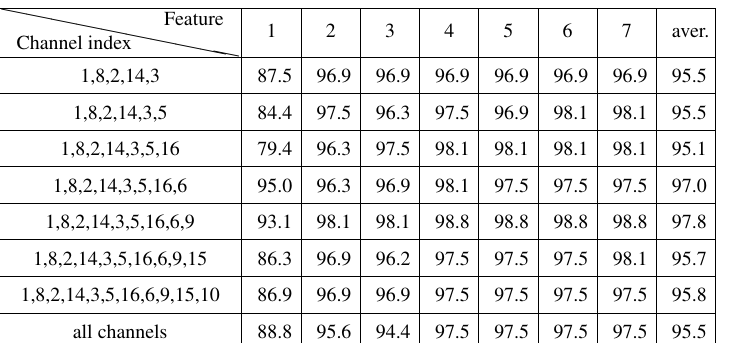
Table 4. Classification rates for different number of features as increasing the number of channels of the sensor